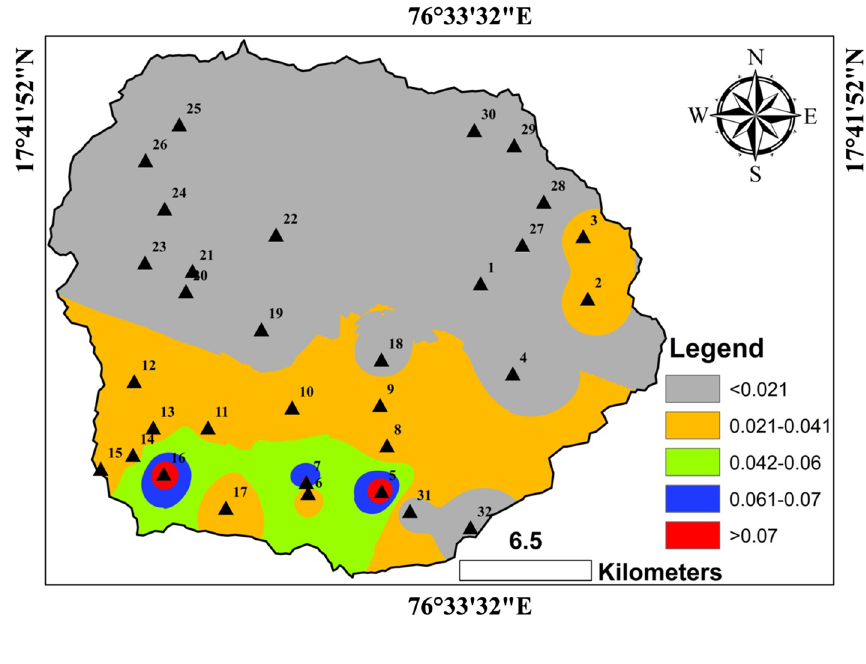
Fig. 17 Geospatial distribution of iron